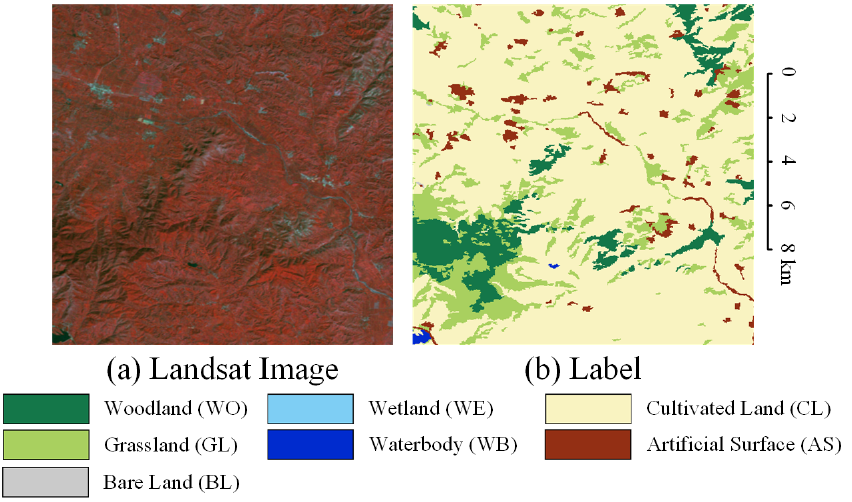
Figure 4. Small target objects in Landsat images. ( a ) The pseudocolor Landsat image. ( b ) The semantic segmentation